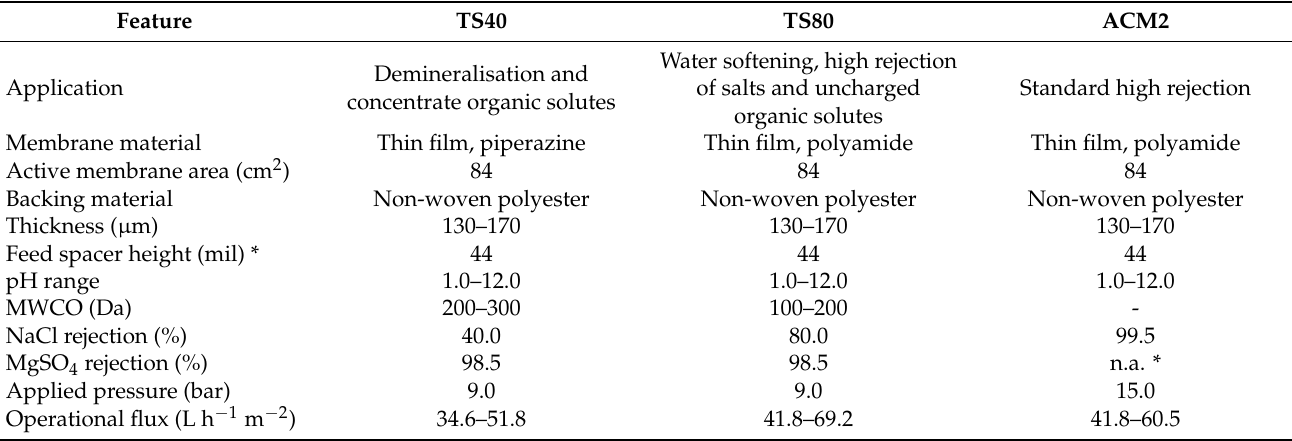
Table 1. Comparative features of the utilised